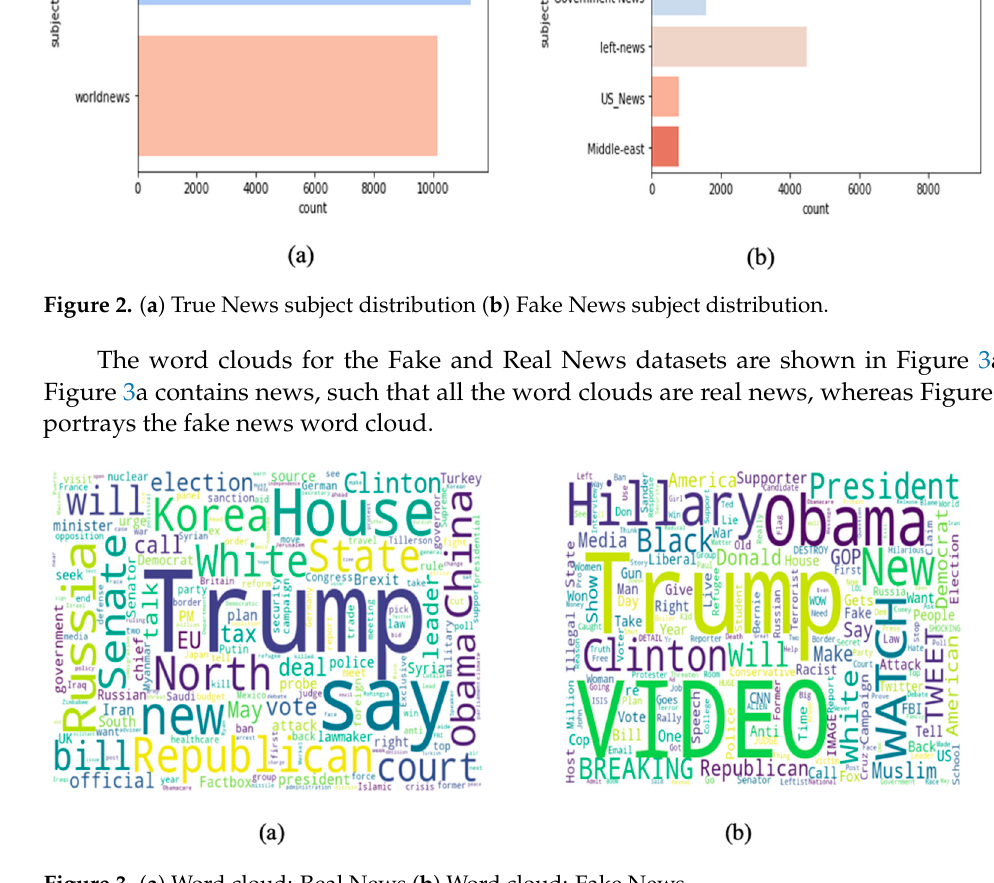
Figure 3. ( a ) Word cloud: Real News ( b ) Word cloud: Fake